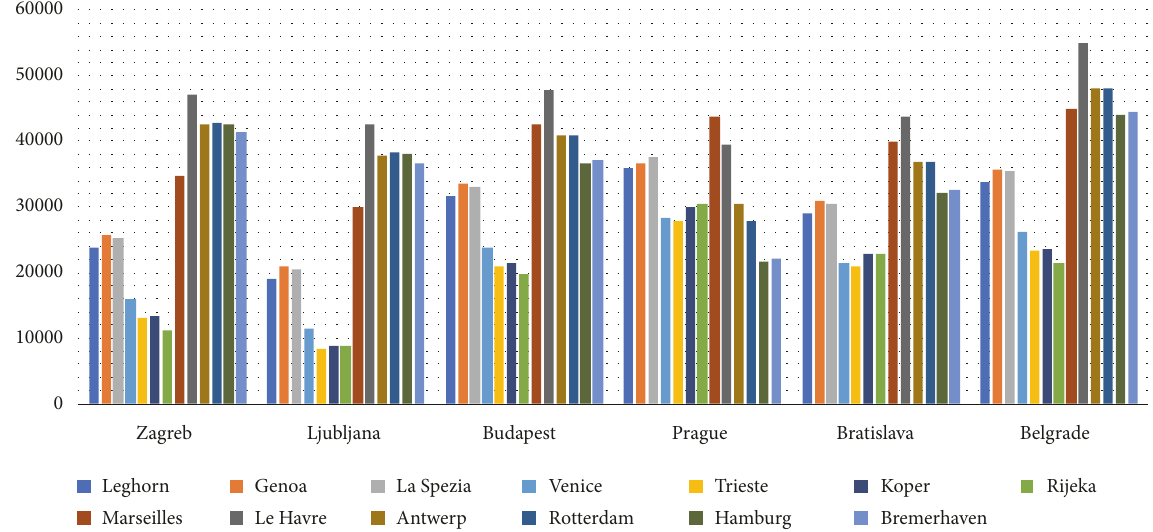
Figure 11: Generalised costs for a full train (€) from the ports considered in the analysis, towards Central-Eastern European destinations. Optimisation by generalised